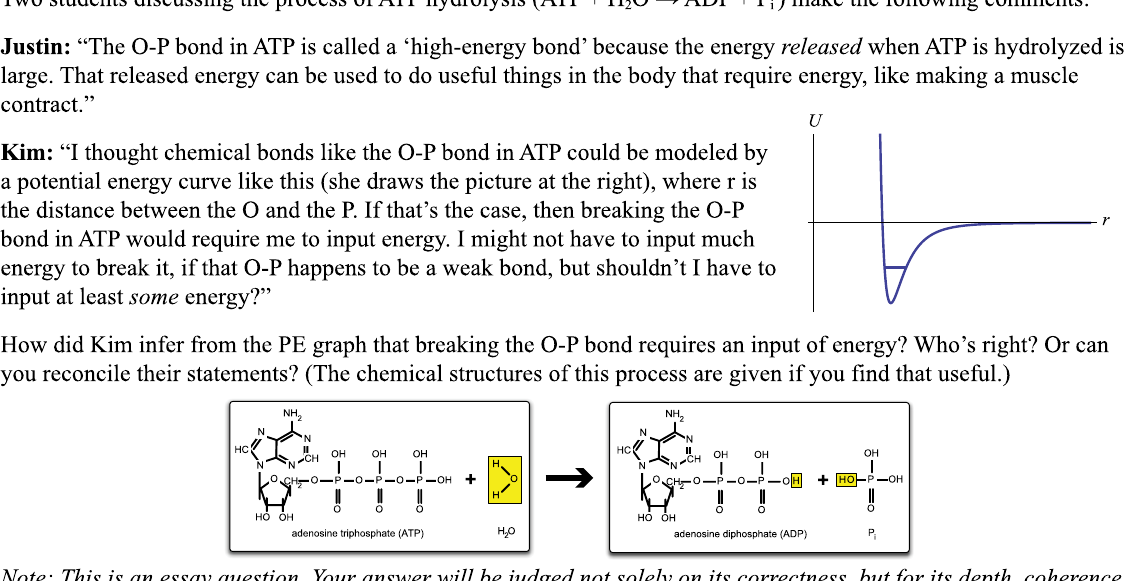
FIG. 1. The reconciliation essay question given to students on the midterm